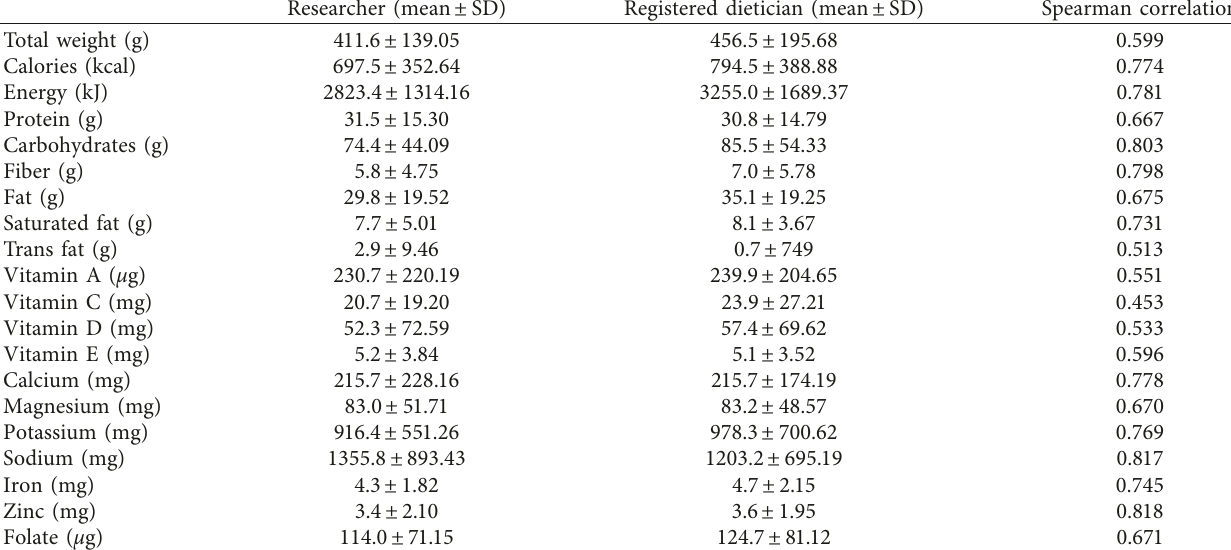
Table 1: Software analysis data for estimates by researcher and registered dietician for macro- and